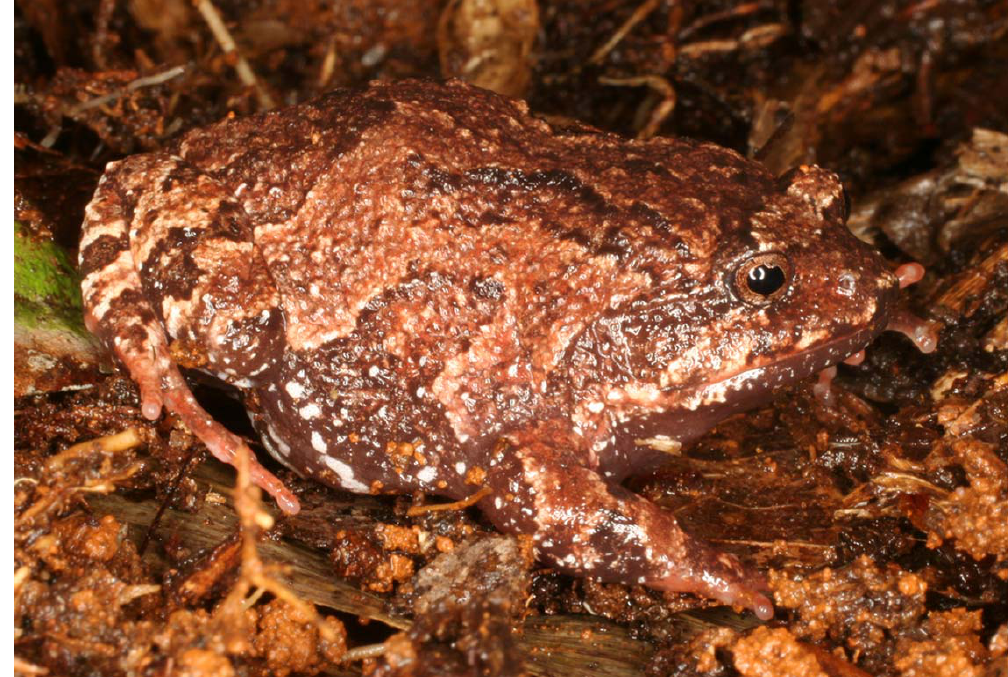
Figure 1. Zachaenus carvalhoi from Parque Nacional do Caparaó , state of Espírito Santo, Brazil. Photo by Miguel T.